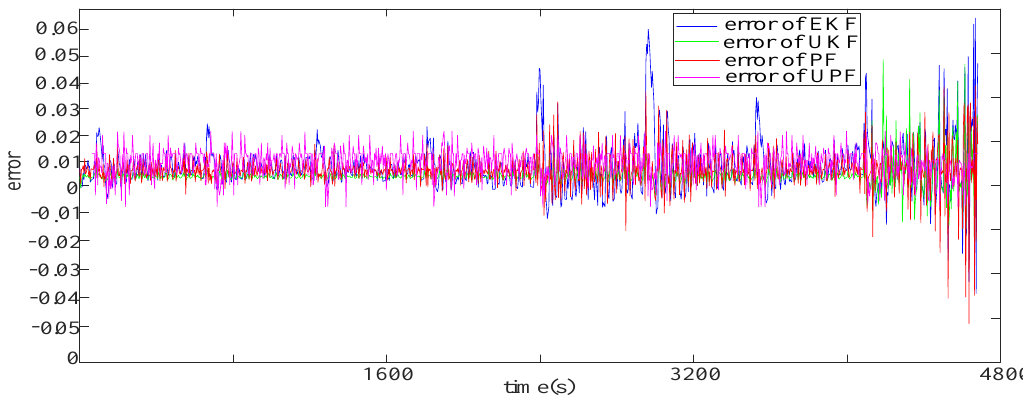
Figure 22. Estimation error curves of different methods. Table 11. Maximum Estimation Error of Different Methods at −10 °C.